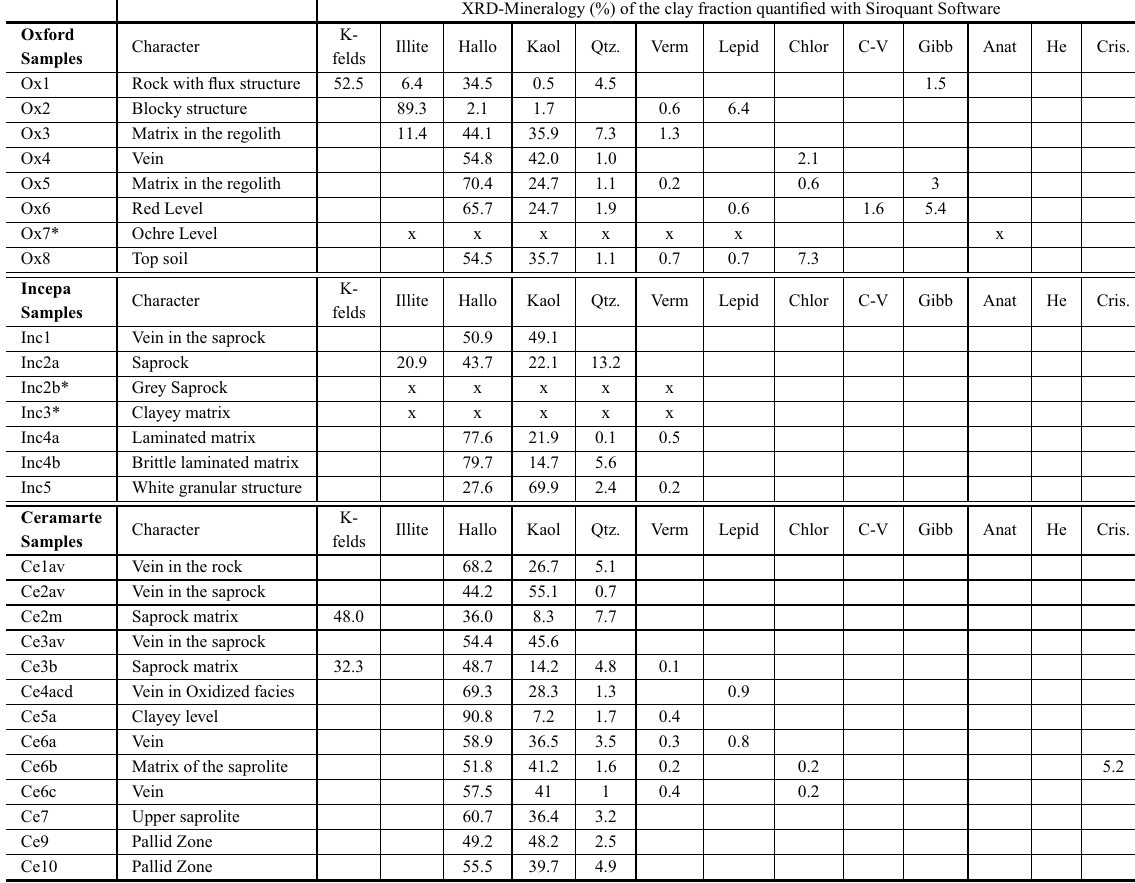
The kaolin samples from Campo Alegre